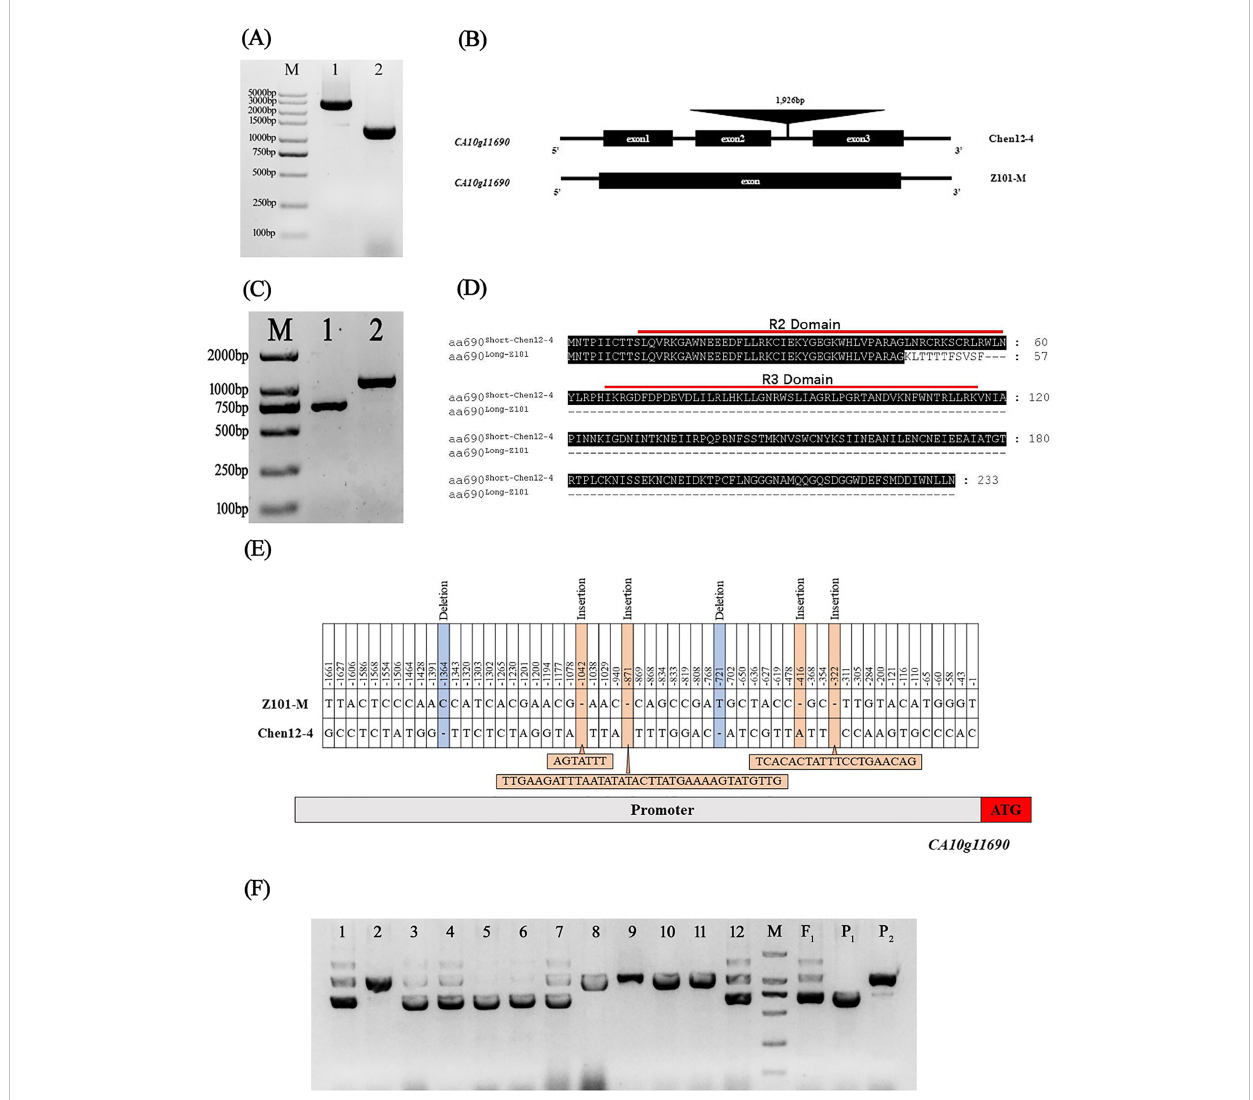
FIGURE 4 Sequence analysis of CA10g11690 in two parents and development of a functional Marker. (A) PCR products for the gDNA of the CA10g11690 in two parents, M: Marker DL5000, 1: ‘ Chen12-4 ’ , 2: ‘ Z101-M ’ . (B) The gene structure of CA10g11690 in two parents. (C) RT-PCR products for the CDS of the CA10g11690 in two parents, M: Marker DL2000, 1: ‘ Chen12-4 ’ , 2: ‘ Z101-M ’ . (D) Putative amino acid sequences of two different transcripts. (E) Sequence variation analysis in the promoter region of CA10g11690 in two parents. (F) PCR fragments ampli fi ed using SCAR marker